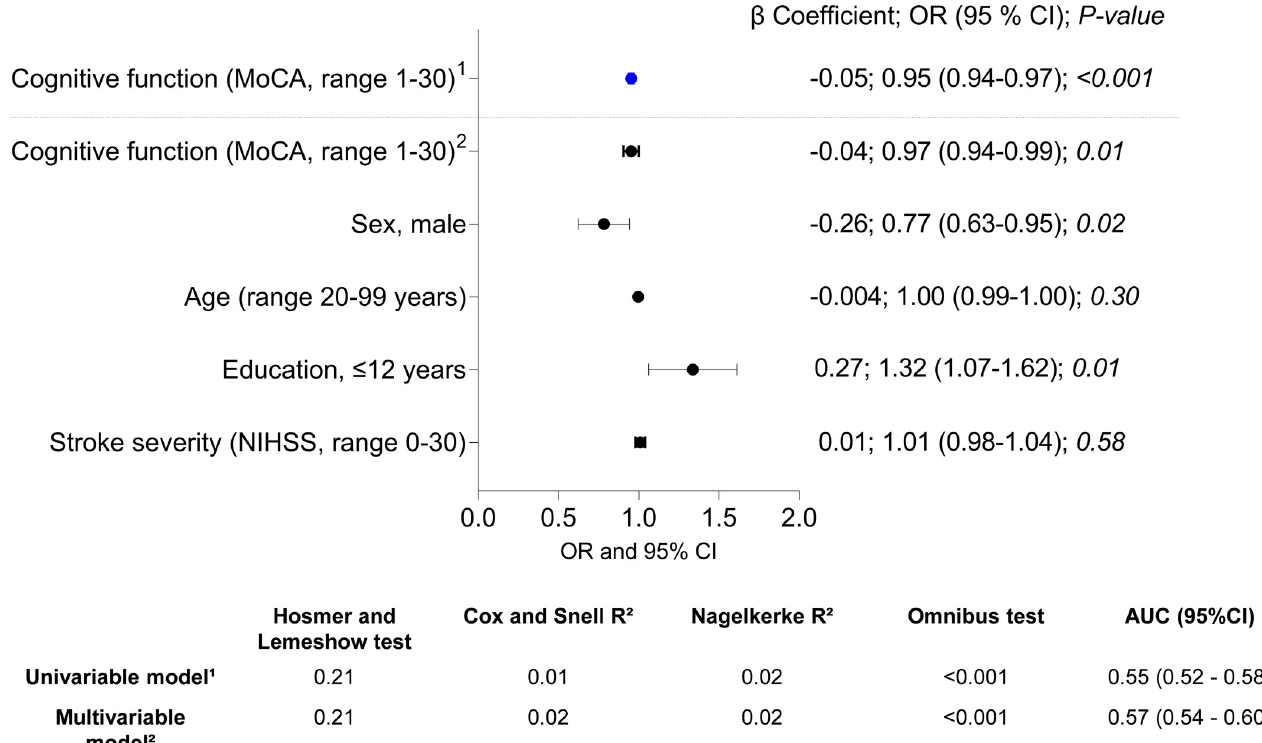
Fig 5. Forest plot with the results of binary logistic regression analyses showing the explanatory value of independent variables for subjective cognitive complaints (SCCs) 3 months after stroke. MoCA, Montreal Cognitive Assessment; NIHSS, National Institutes of Health Stroke Scale; AUC, area under the curve; CI, confidence interval; ORs, odds